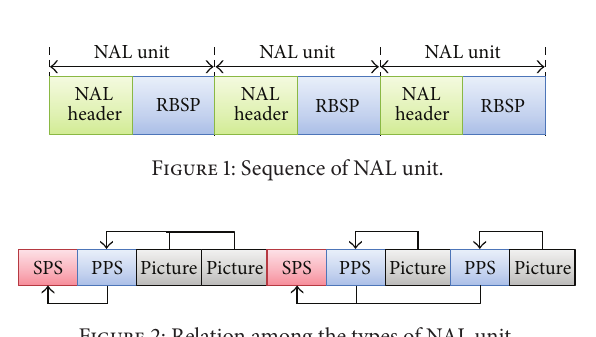
Figure 2: Relation among the types of NAL